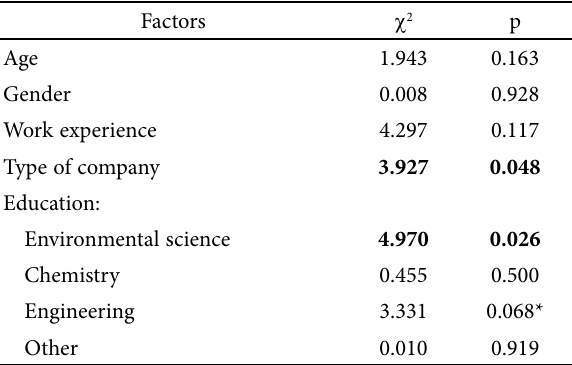
Table 2. Dependence of the EIA practitioners’ attitude towards changes on different factors (bold values are significant at p < 0.05). Survey results: all respondents